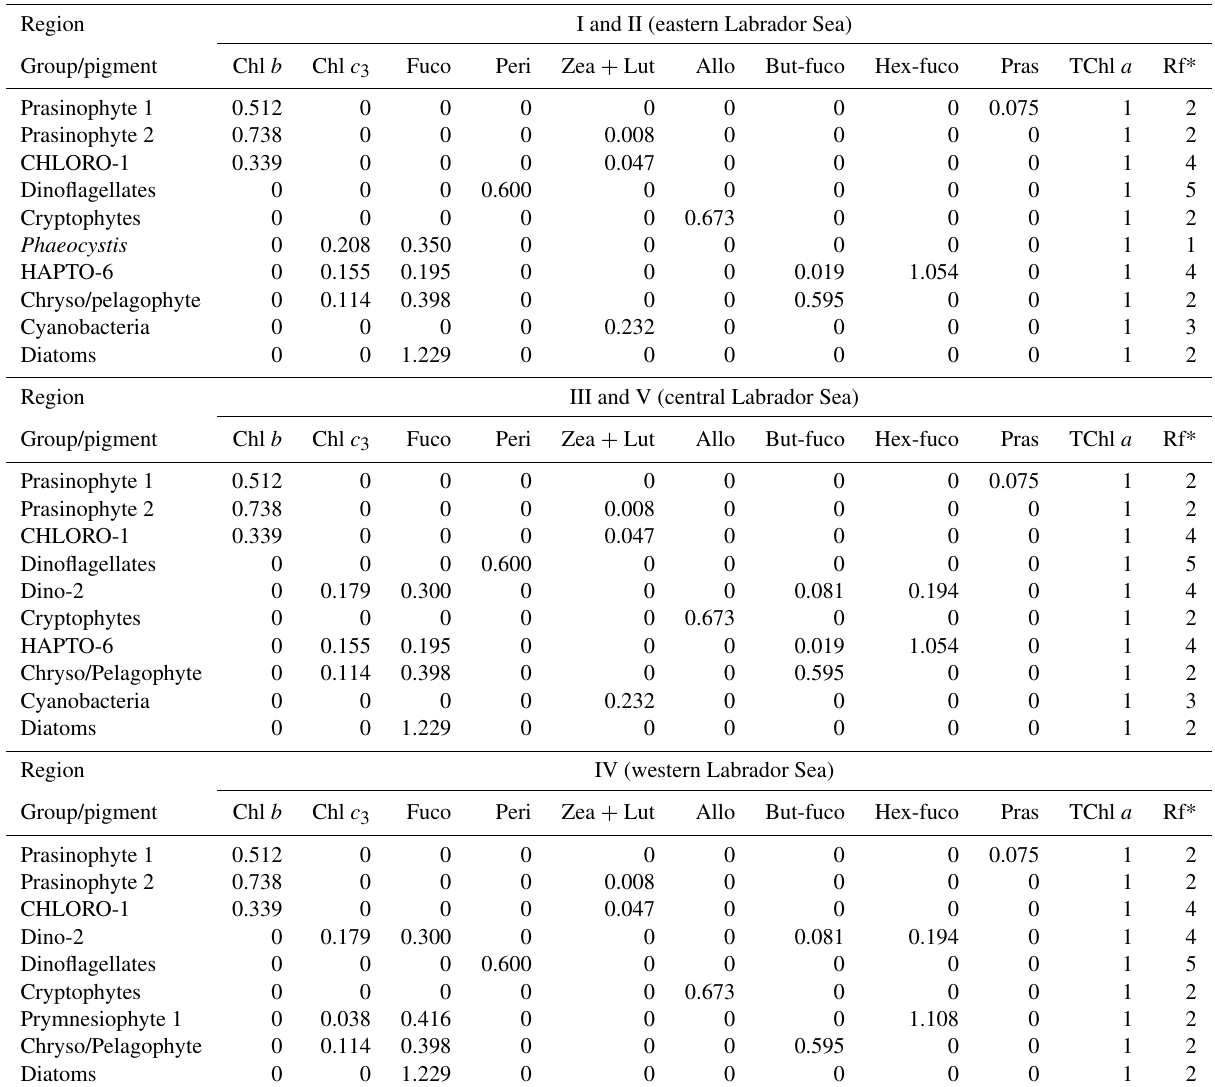
Table 3. Initial ratio matrix of accessory pigment to chlorophyll a for distinct algal groups for each cluster group. * Rf refers to the literature where the pigment ratios were extracted. See explanation of each group in the methods